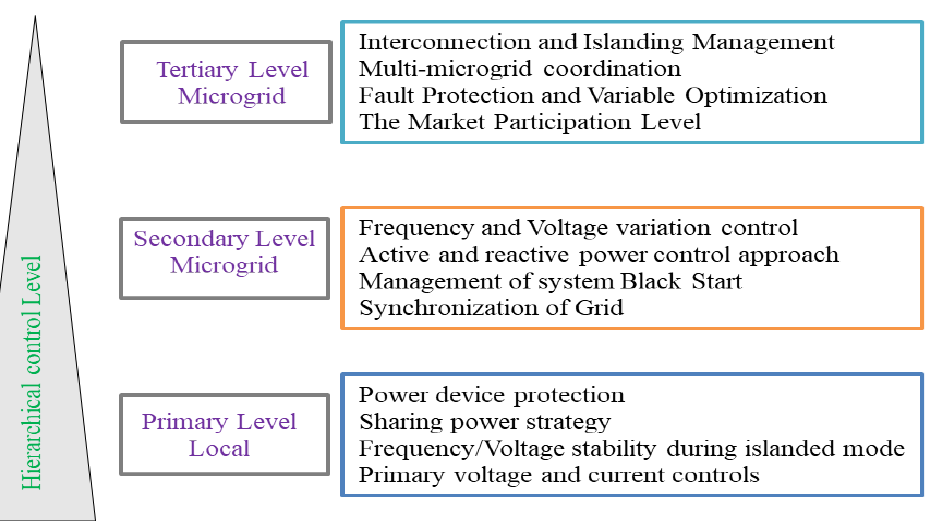
Figure 7. The Key features of control levels of a hierarchical Control strategy.